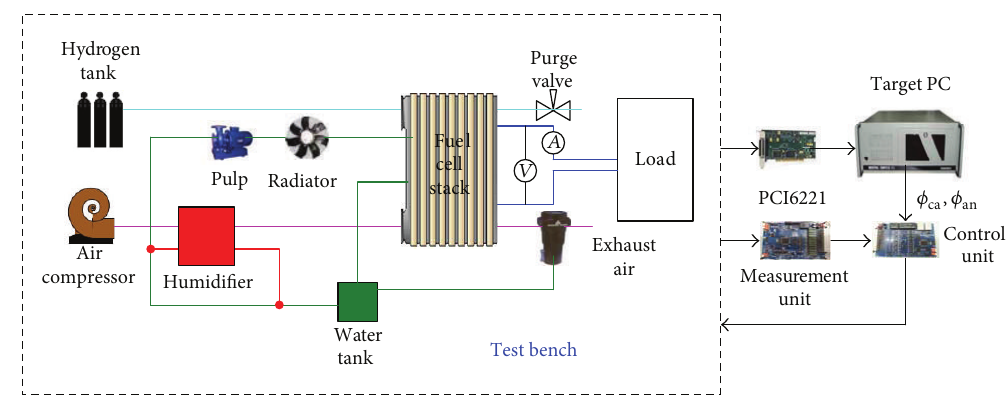
Figure 1: The Schematic diagram of HIL test